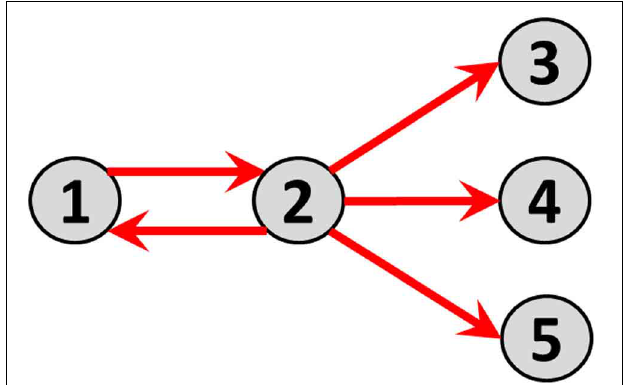
FIGURE 1 | Direct causal directed connections between nodes, corresponding to the toy example defined by the multivariate autoregressive model in Equation